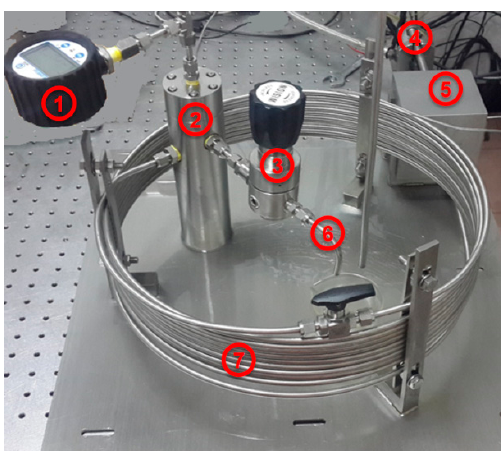
Figure 1. The designed test system for injection rate based on the long tube method.